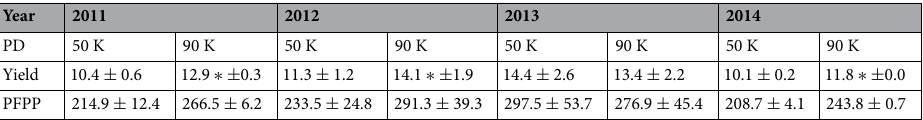
Table 1. Effects of planting density on maize yield response and P-use efficiency in the experimental plot during four consecutive cropping years. PD, Plant density; 90 K, at a planting density of 90,000 plants ha −1 ; 50 K, at a planting density of 50,000 plants ha −1 ; Yield, crop yield, t ha −1 ; PFPP, the partial factor productivity from applied P, kg yield per kg fertilizer, kg kg −1 ; all data presented are mean values (± SD); asterisk indicates significant difference ( P ≤ 0.05) between different planting